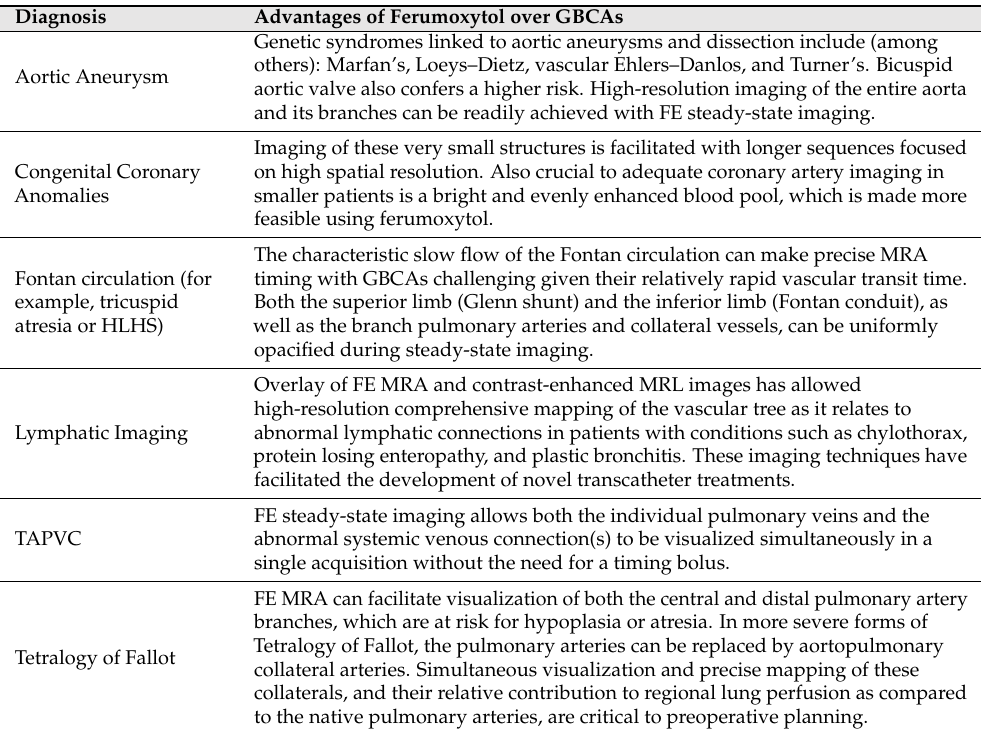
Table 3. Advantages of Ferumoxytol over GBCAs in Specific Congenital Heart